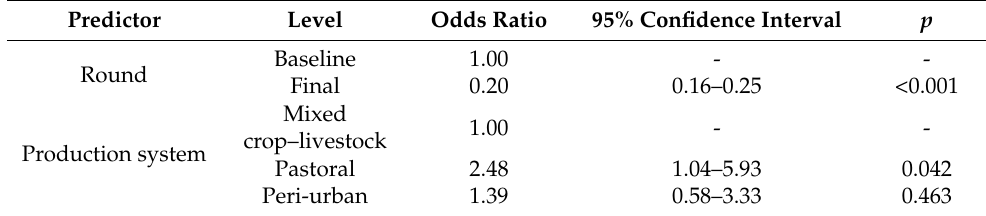
Table 15. Calf diarrhea risk model